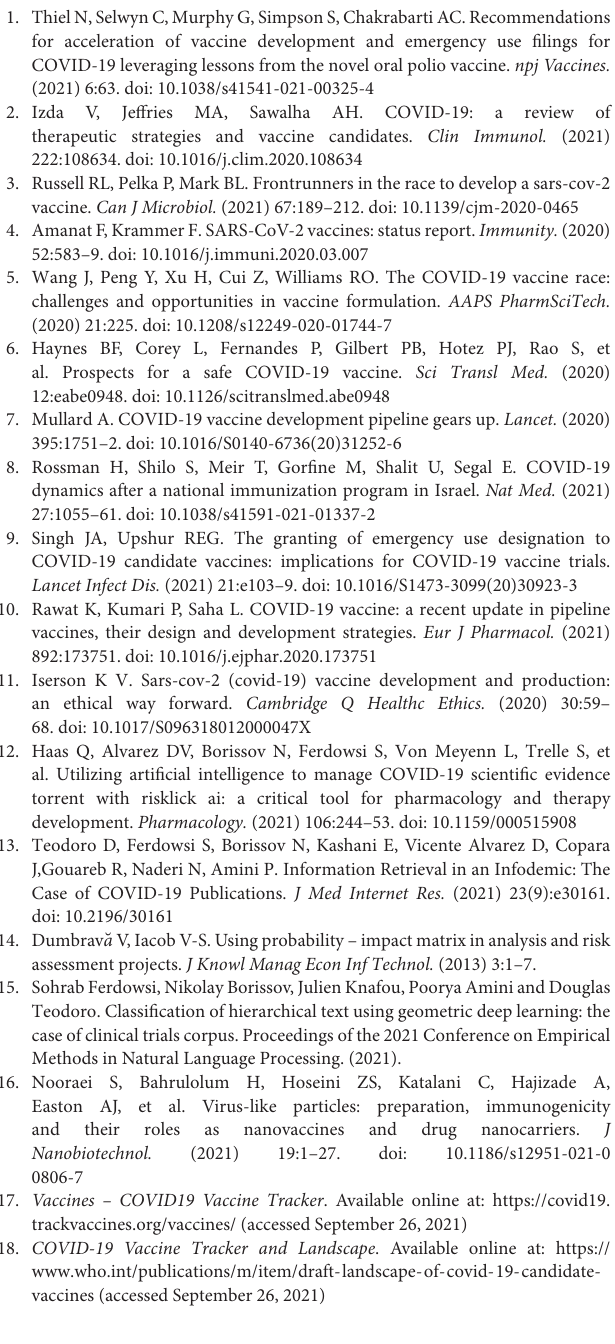
Supplementary Table 2 | Definition of the variables used to assess the risk of vaccine